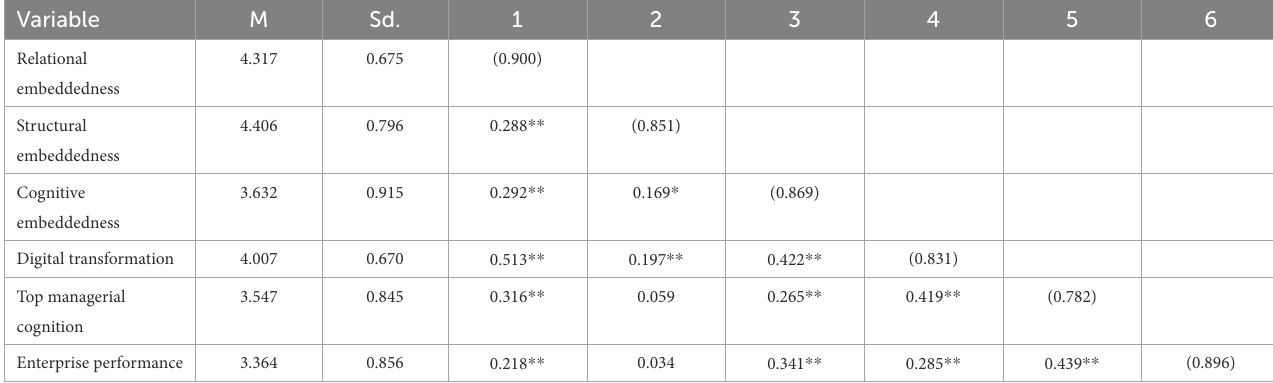
TABLE 3 Mean value, standard deviation, and correlation coefficient of each variable. Variable M Sd.